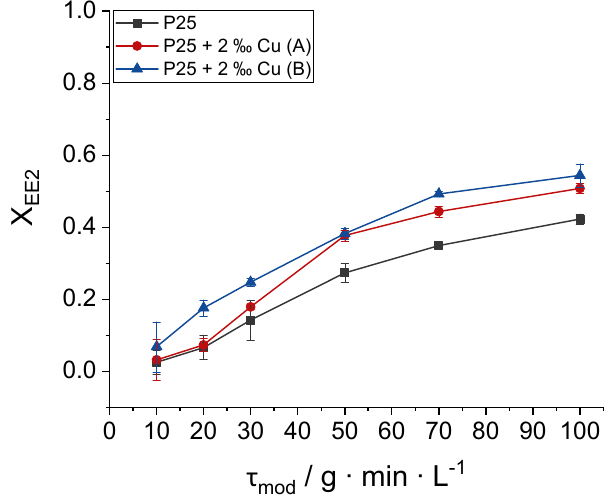
Figure 13. Investigation of the influence of copper ‐ doping after immobilization by spray coating, triple determination. Experiments were carried out in the microgap reactor; reactant: EE2 (17 α‐ ethi ‐ nyl estradiol), c start = 14.5 μ g L − 1 ; catalysts: P25, immobilized by spray coating on a steel substrate [X6CrNiMoTi17 ‐ 12 ‐ 2], calcination: t = 2 h, ϑ = 500 °C, m = 90 mg; P25 + 2‰ Cu, immobilized P25 catalyst impregnated with copper acetate solution (c(Cu(OAc) 2 ) = 8.32 g L − 1 , m = 0.07 g, x Cu = n Cu n Ti − 1 ≈ 2‰), A: impregnation before spray coating, B: impregnation after spray coating; reaction: microgap reactor, E = 362.5 mW cm − 2 , λ = 365 nm; analysis: EE2 content determination by